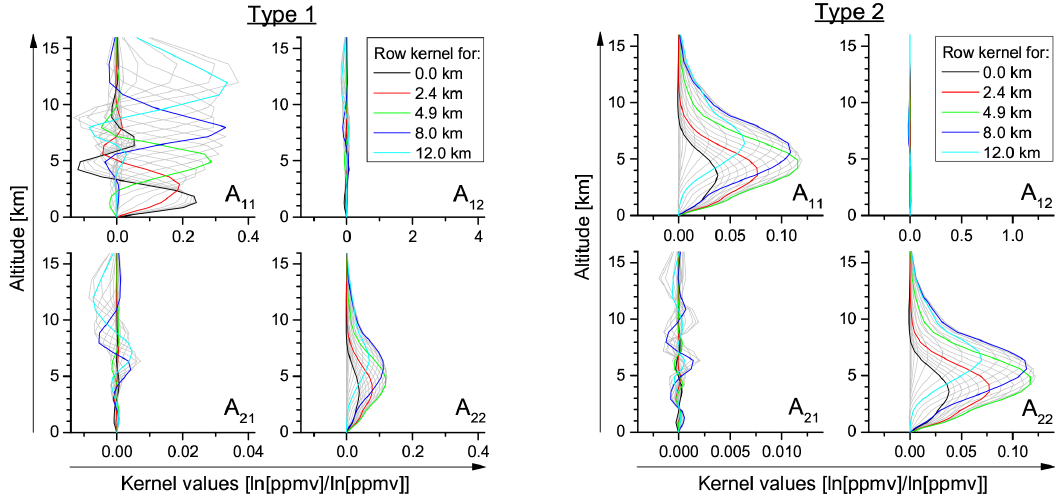
Figure 1. Example of an averaging kernel for an observation over the tropical ocean. Shown are the row entries of the four blocks of the MetOp/IASI full averaging kernel matrix in the {H 2 O, δ D} proxy basis system. Left for the Type 1 product (original retrieval output) and right for the Type 2 product (after a posteriori